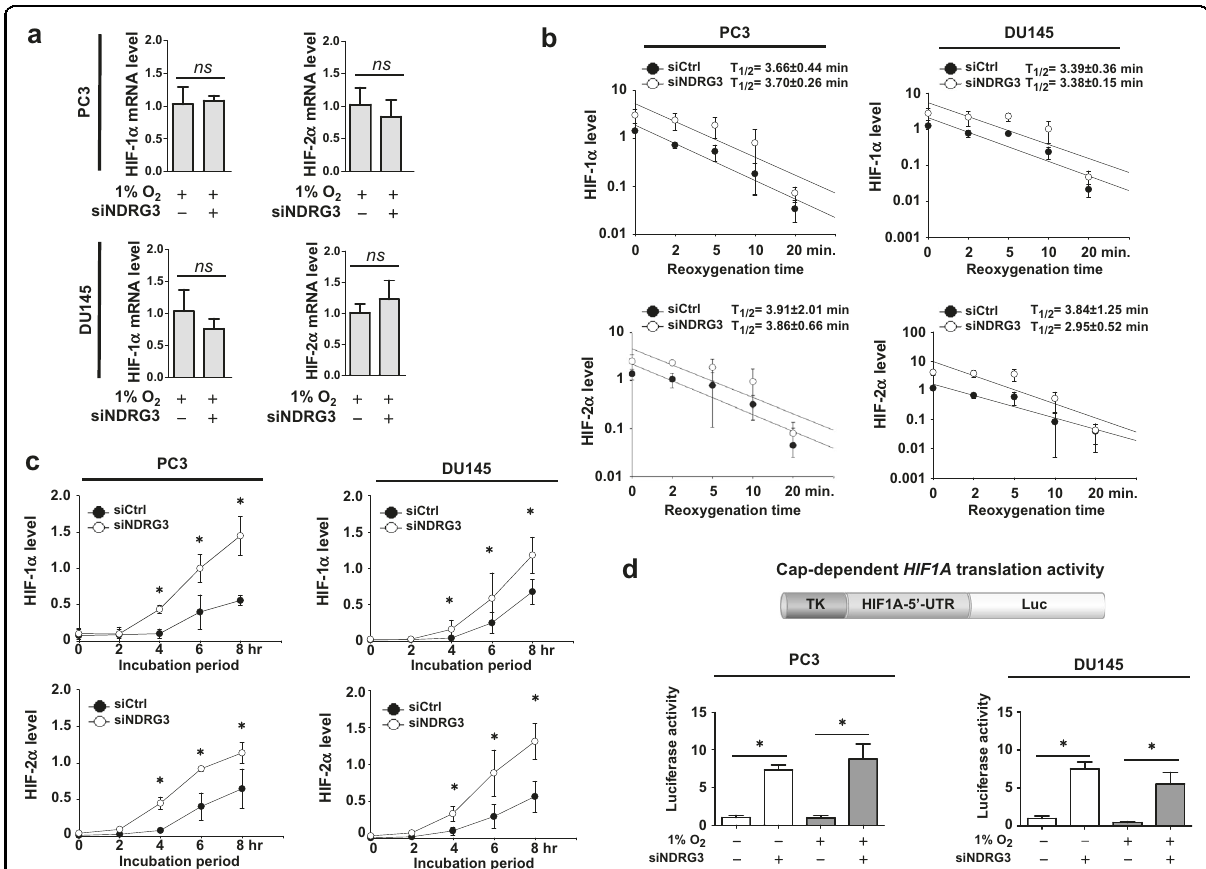
Fig. 2 NDRG3 inhibits the cap-dependent translation of HIF-1 α . a PC3 and DU145 cells, which had been transfected with NDRG3-silencing siRNA, were incubated under hypoxia for 24 h and subjected to RT-qPCR to measure the mRNA levels of HIF-1 α and HIF-2 α (means + s.d., n = 3). ns denotes “ not signi fi cantly different. ” b The transfected PC3 or DU145 cells were incubated under hypoxia for 8 h, followed by re-oxygenation at 21% O 1 α and HIF-2 α proteins were immunoblotted and their blots were quanti fi ed using the ImageJ program. Relative band intensities were normalized to the corresponding β -tubulin intensities. Each symbol represents the mean ± s.d. ( n = 3), and the linear regression was plotted using the